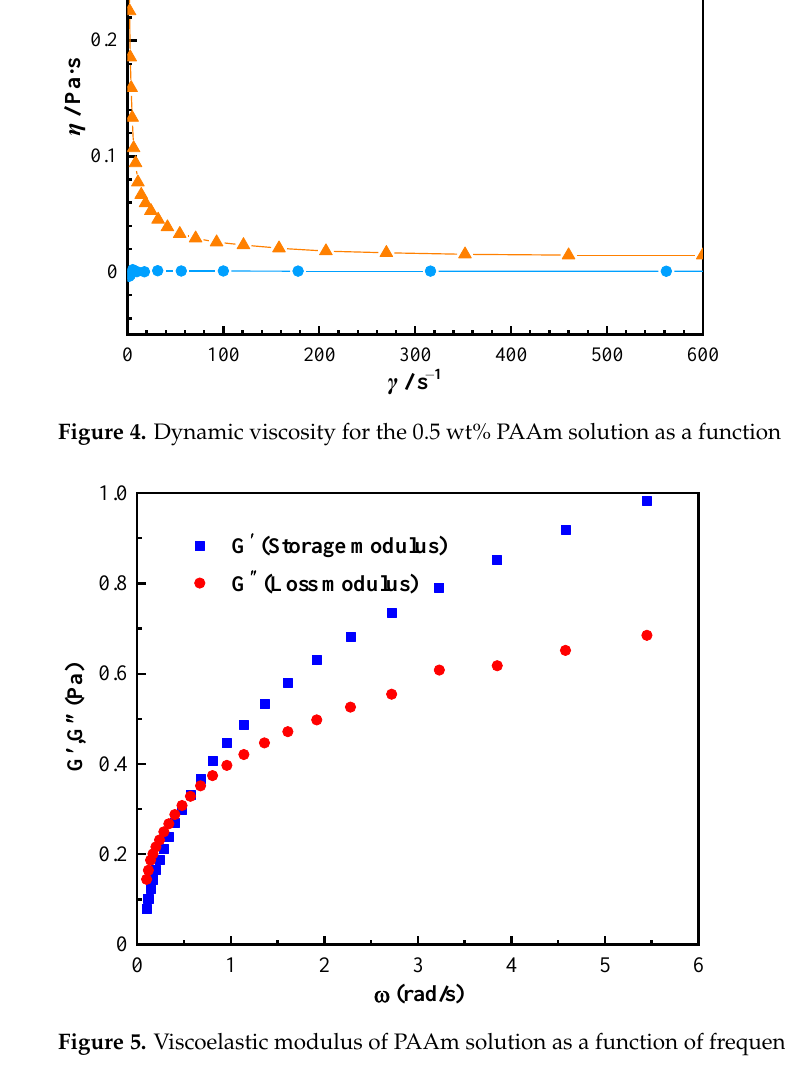
Figure 4. Dynamic viscosity for the 0.5 wt% PAAm solution as a function of the shear rate.